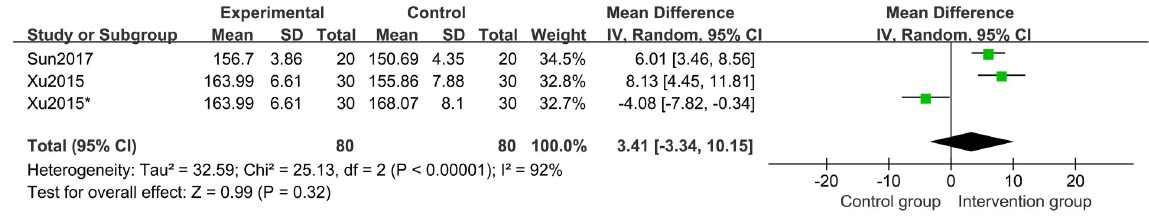
Fig 18. Forest plot of predicting adult height (PAH).